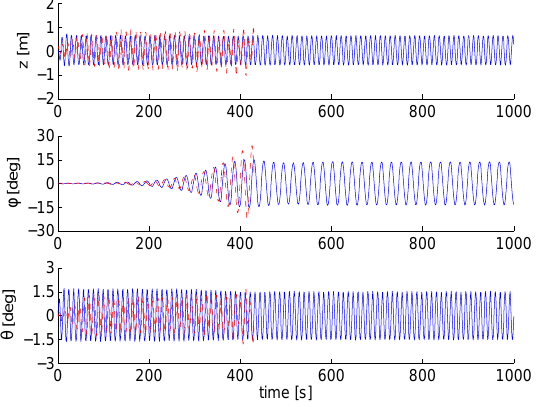
Figure 2: Exp. 1172. Exp. dashed red, sim. solid blue.